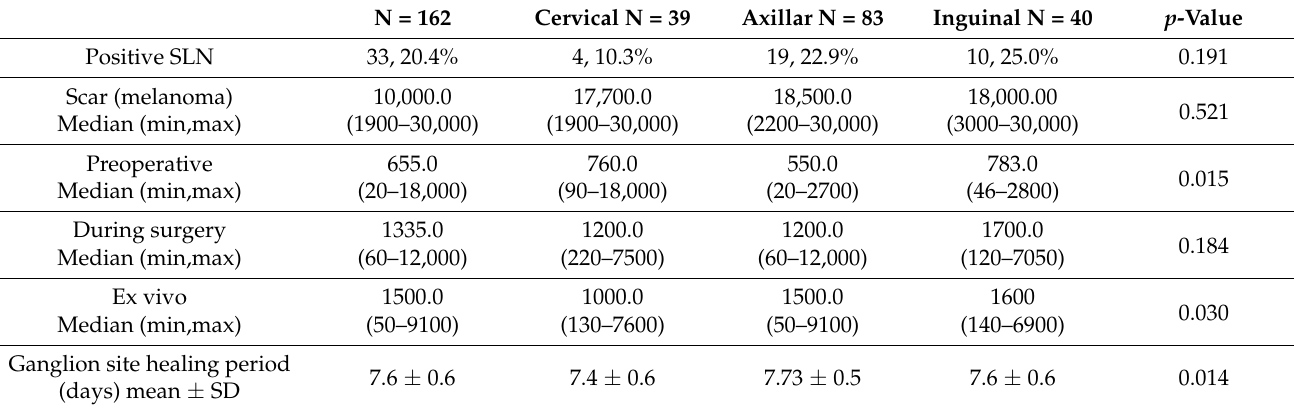
Table 2. Characteristics of lymph